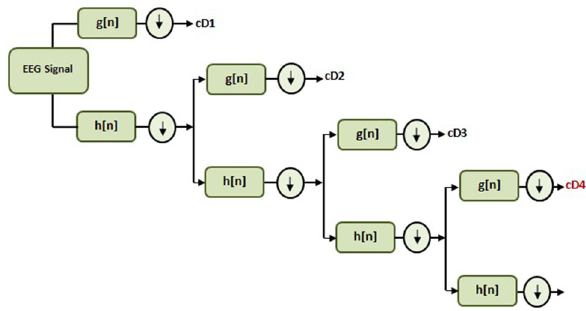
Fig. 5 Multi-level signal decomposition by DWT, h [ n ] is the low pass and g [ n ] is the high pass filter